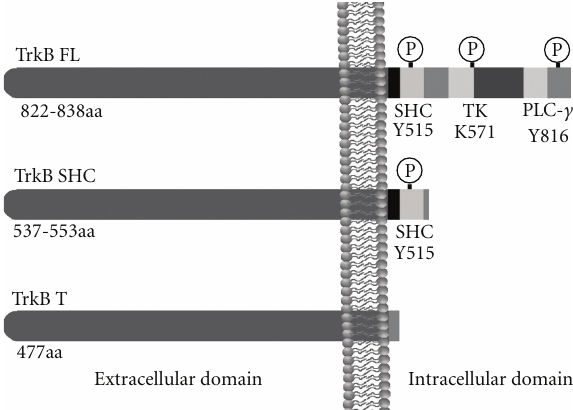
Figure 1: TrkB isoforms structure and functional domains. The extracellular portion of the receptor is conserved. The intracellular domain di ff ers among the isoforms. TrkB FL contains a tyrosine kinase domain, a SHC-binding domain, and a PLC- γ -binding domain. TrkB SHC contains a SHC-binding domain and TrkB T does not have any functional